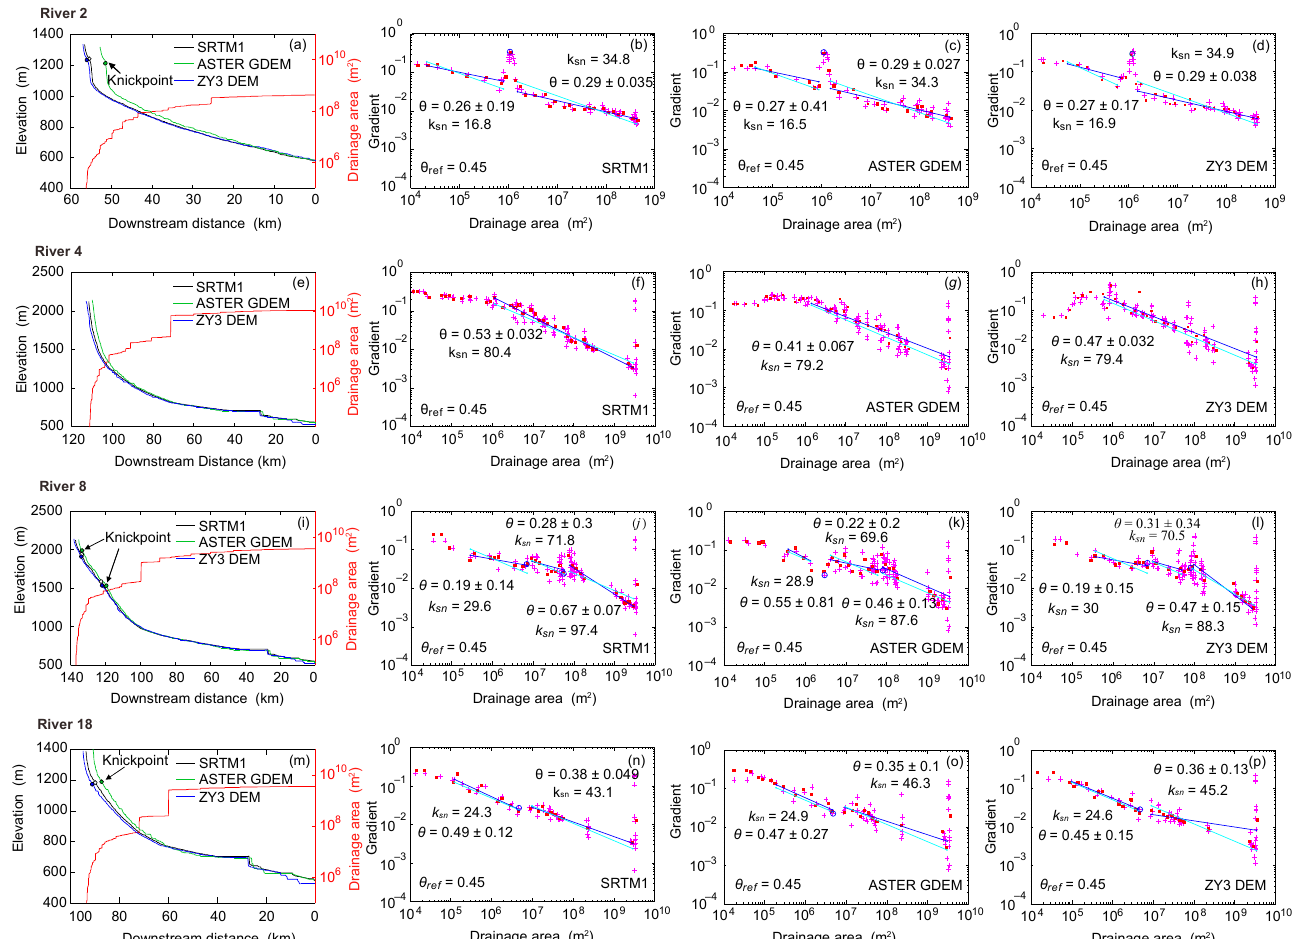
Figure 9. Representative examples of river longitudinal profiles, and SA plot (log-log SA, where the relationship is between local channel gradient and drainage area). K sn was derived from SRTM, ASTER GDEM, and ZY3 DEM by using a reference concavity θ ref = 0.45. Rivers 2, 4, 8, and 18 are the rivers with one vertical-step knickpoint, no knickpoint, two slope-break knickpoints, and one slope-break knickpoint. The red lines in the first column are the drainage area of upstream. ( a , e , i , m ) are the longitudinal profiles and drainage areas along the downstream distance for River 2, 4, 8, and 18, respectively. ( b , f , j , n ) are the knickpoint extraction from the SRTM1 for River 2, 4, 8, and 18, respectively. ( c , g , k , o ) are the knickpoint extraction from the ASTER GDEM for River 2, 4, 8, and 18, respectively. ( d , h , l , p ) are the knickpoint extraction from the ZY3 DEM for River 2, 4, 8, and 18, respectively.